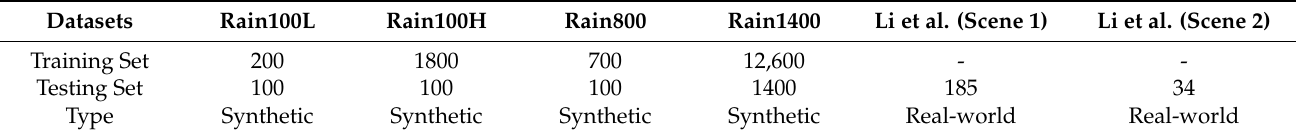
Table 1. Descriptions of synthetic and real-world